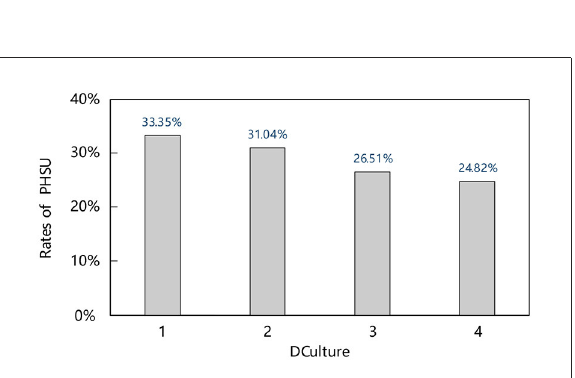
FIGURE3 Rates of PHSU among rural migrants in different